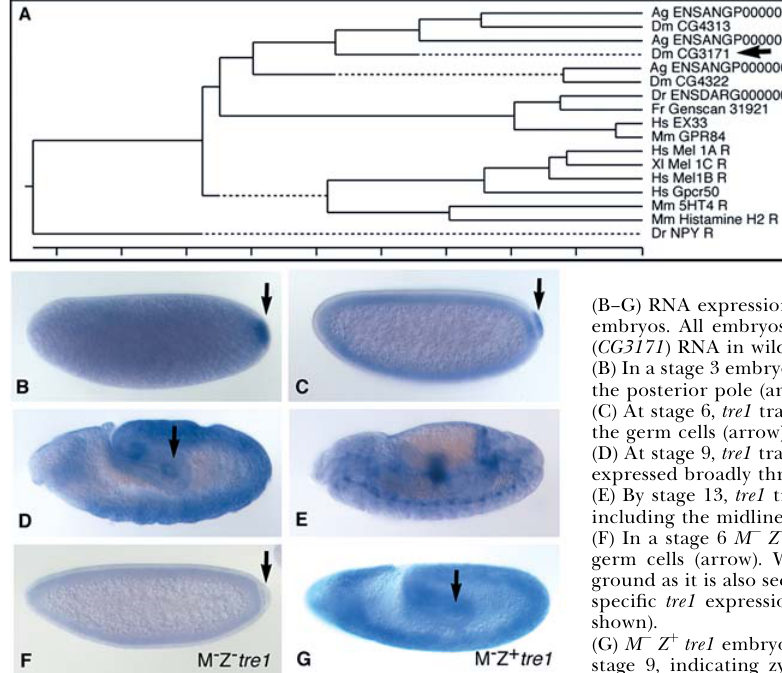
Figure 2. Phylogenetic Tree of Tre1 and Expression Patterns of CG3171 ( tre1 ) (A) Phylogenetic tree of Tre1 protein with other closely related GPCRs (drawn using ClustalW of MegAlign program from DNA- STAR). Tre1 (indicated by arrow) is closely related to a group of fly, Anopheles , and vertebrate GPCRs. Among known ligand– receptor pairs, this novel receptor group is most closely related to melatonin, histamine, and serotonin receptors. Abbreviations: Ag, Anopheles gambiae ; Dm, Drosophila melanogaster ; Dr, Danio rerio ; Fr, Fugu rubripes ; Hs, Homo sapiens ; Mm, Mus musculus ; Xl, Xenopus laevis . (B–G) RNA expression pattern of CG3171 ( tre1 ). Anterior is to the left in all embryos. All embryos are in lateral views. (B–E) Expression pattern of tre1 ( CG3171 ) RNA in wild-type embryos. (B) In a stage 3 embryo, tre1 transcript is provided maternally and enriched at the posterior pole (arrow). (C) At stage 6, tre1 transcript is degraded in somatic tissues, but protected in the germ cells (arrow). (D) At stage 9, tre1 transcript is still detected in germ cells (arrow), but is also expressed broadly throughout the soma. (E) By stage 13, tre1 transcript is highly expressed in several somatic tissues, including the midline glial, cuprophilic cells, glial cells, and CNS. (F) In a stage 6 M (cid:1) Z (cid:1) tre1 embryo, no specific tre1 transcript is detected in germ cells (arrow). Weak staining in somatic tissues represents the back- ground as it is also seen with sense control RNA probe. At stage 13, weak but specific tre1 expression is detected in cuprophilic cells and CNS (data not shown). (G) M (cid:1) Z þ tre1 embryo. tre1 transcript is detected weakly in the germ cells at stage 9, indicating zygotic expression in the germ cells (arrow). Note the broad zygotic tre1 expression similar to (D). DOI: